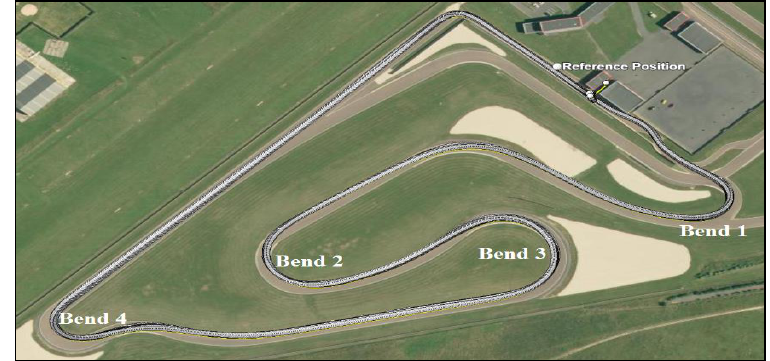
Figure 3. The “Ferté Gaucher” circuit mapped on IGN.